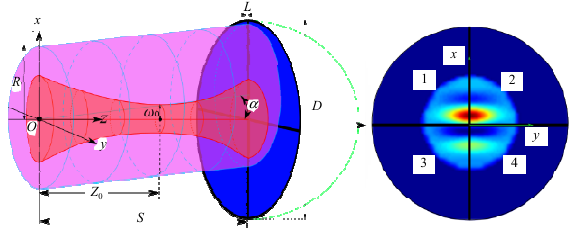
Fig. 2 Simplified schematic of an